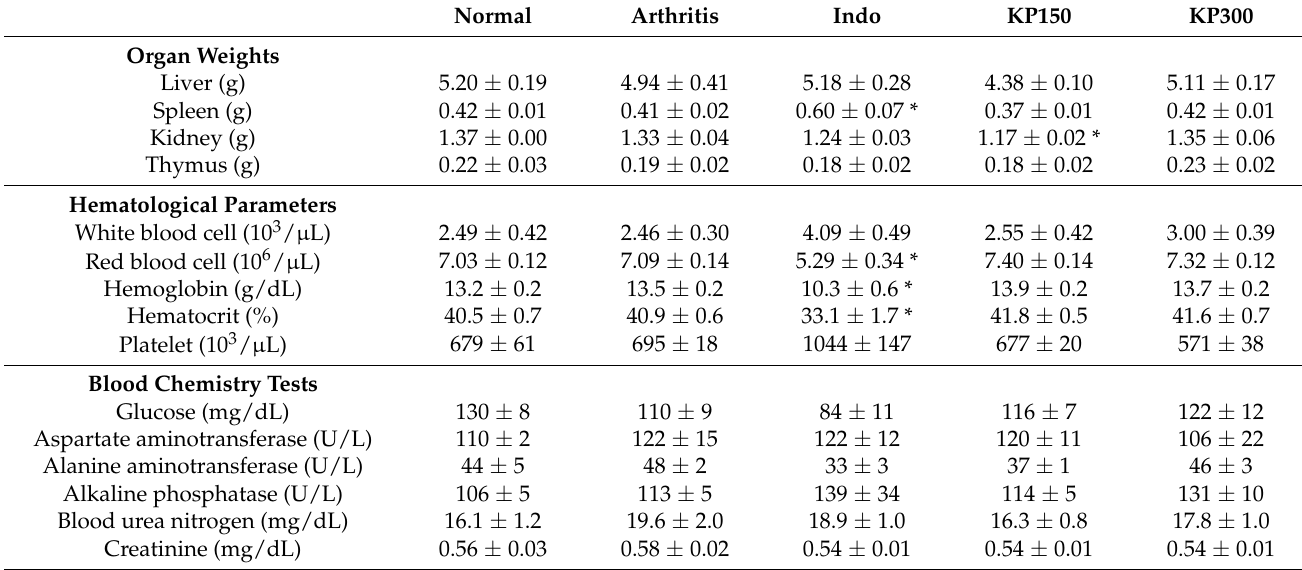
Table 2. The biological parameters of the experimental